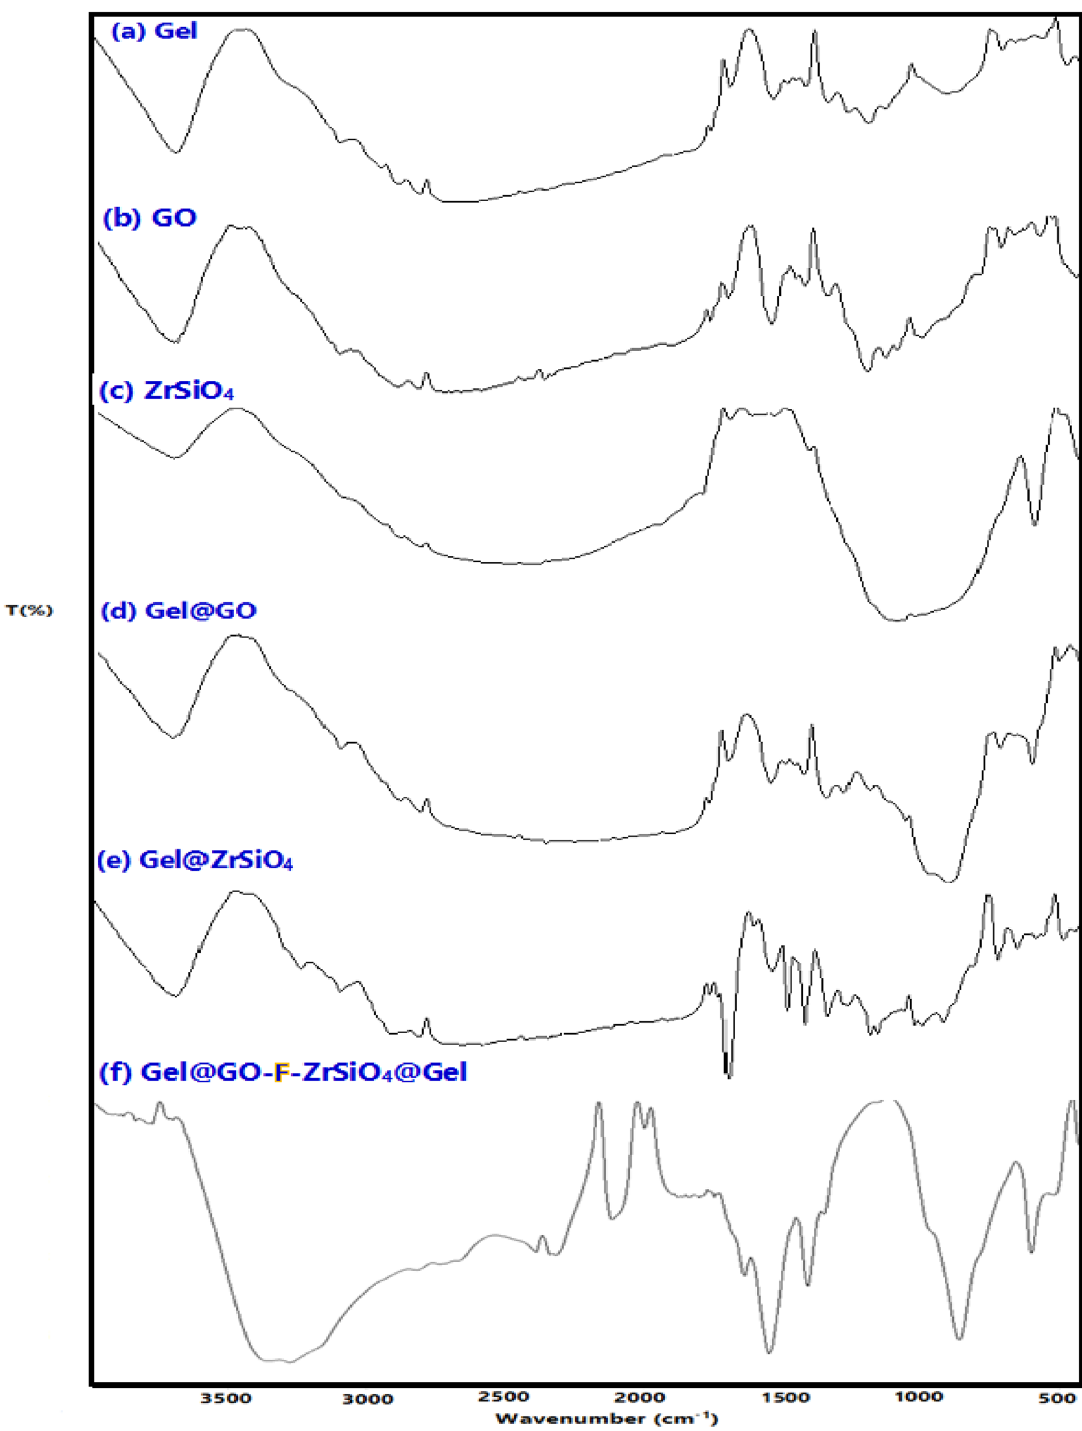
Figure 2. FT-IR of Gel@GO-F-ZrSiO 4 @Gel and various